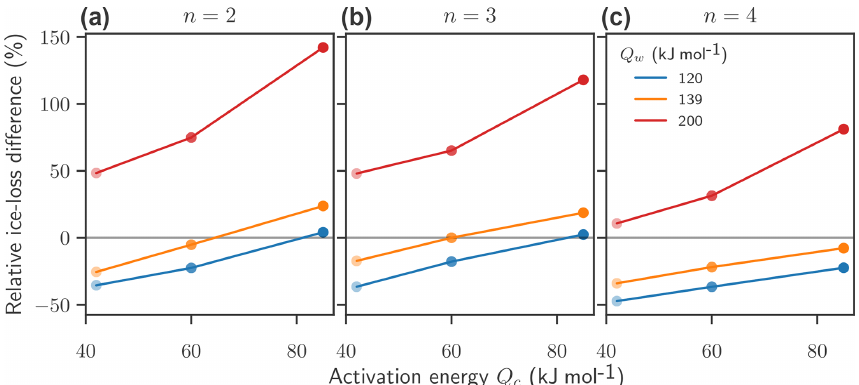
Figure 9. Effect of the flow exponent and activation energies on flow-driven ice loss after 100 years under 2 ◦ C of warming: relative difference in flow-driven ice discharge for n = 2 (a) , n = 3 (b) , and n = 4 (c) for different combinations of the flow exponent n and activation energies Q c and Q w . The reference is always a simulation performed with standard parameters n = 3, Q c = 60kJmol − 1 , and Q w = 139kJmol − 1